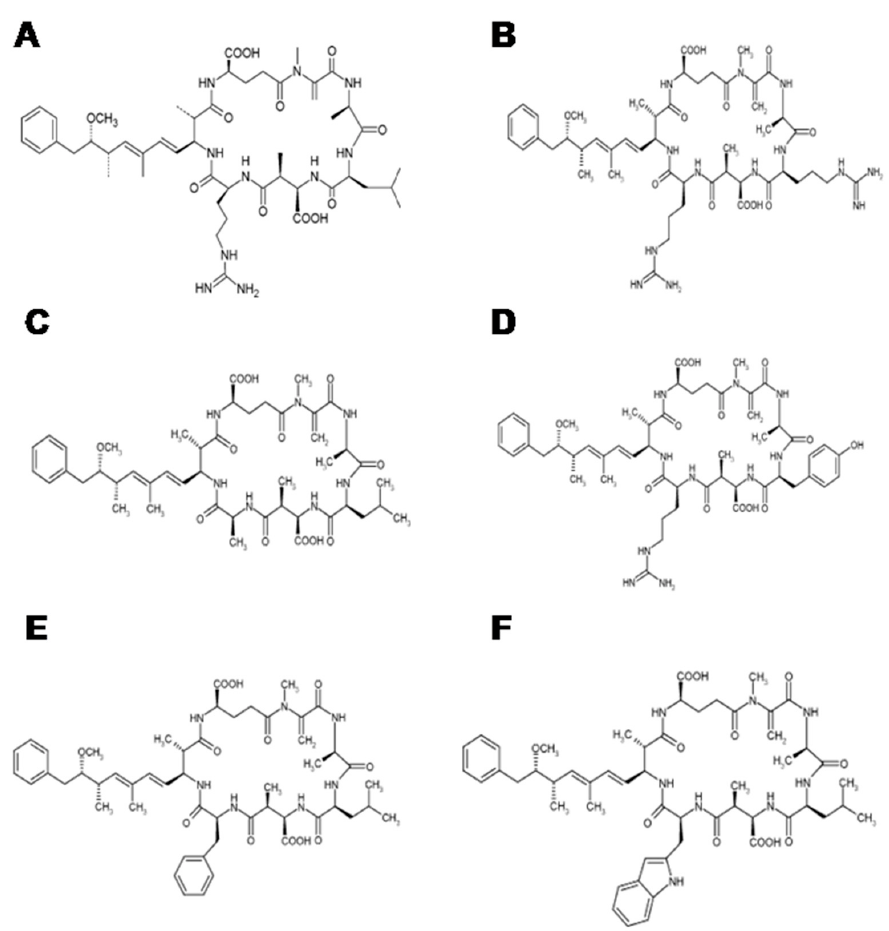
Figure 1. ( A ) Chemical structure of microcystin (MC)-LR, ( B ) microcystin-RR, ( C ) microcystin-LA, ( D ) microcystin-YR, ( E ) microcystin-LF, and ( F ) microcystin-LW.